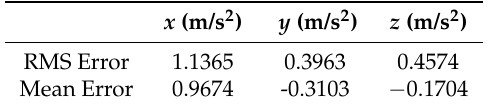
Table 5. X-Sens acceleration measurement error summary.